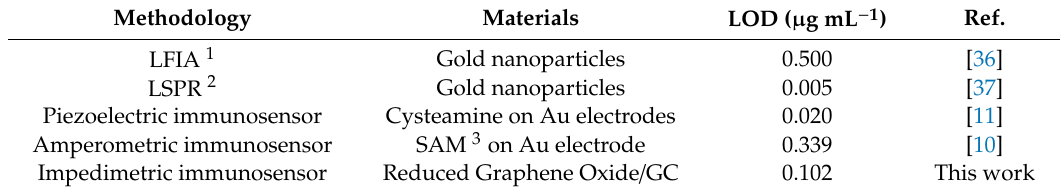
Table 1. Limit of detection comparison of di ff erent biosensors for SEA